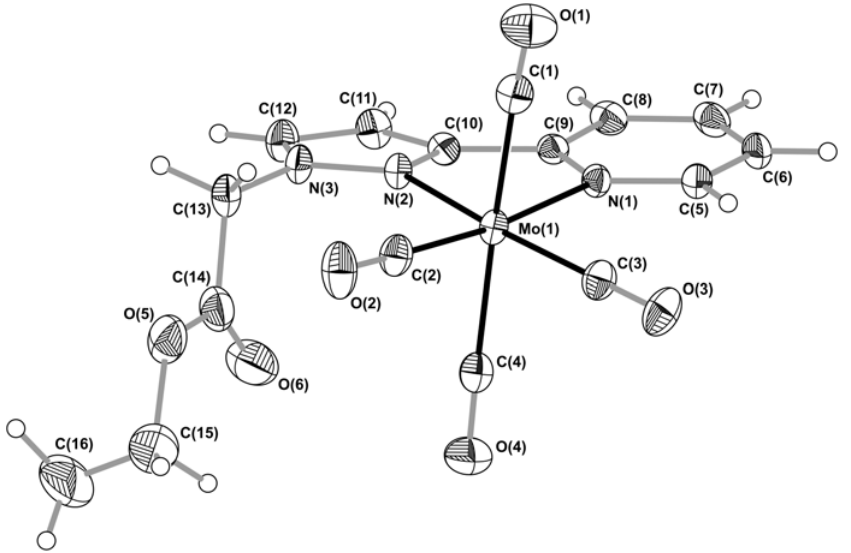
Figure 1. Schematic representation of the complex cis -[Mo(CO) crystal structure of 1 , showing the labelling scheme for all non-hydrogen crystallographically independent atoms. Thermal ellipsoids have been drawn at the 30% probability